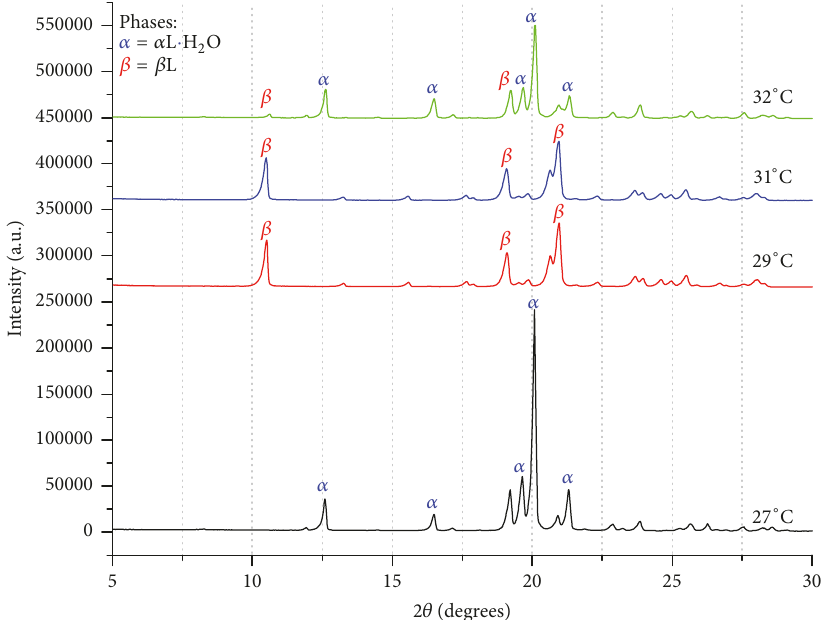
Figure 4: XRD diffractograms of the powders prepared at 27, 29, 31, and 32 ∘ C.